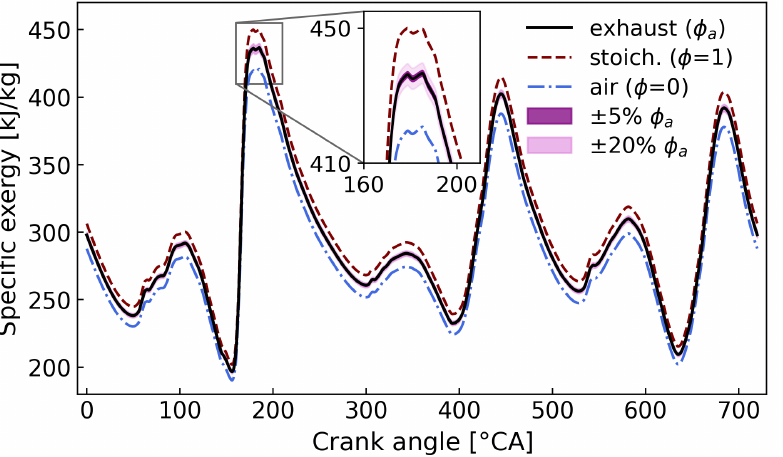
Figure 7. The effect of fuel–air equivalent ratio φ a on the specific exergy at port outlet. Test point (a) 1300 rpm/17.8